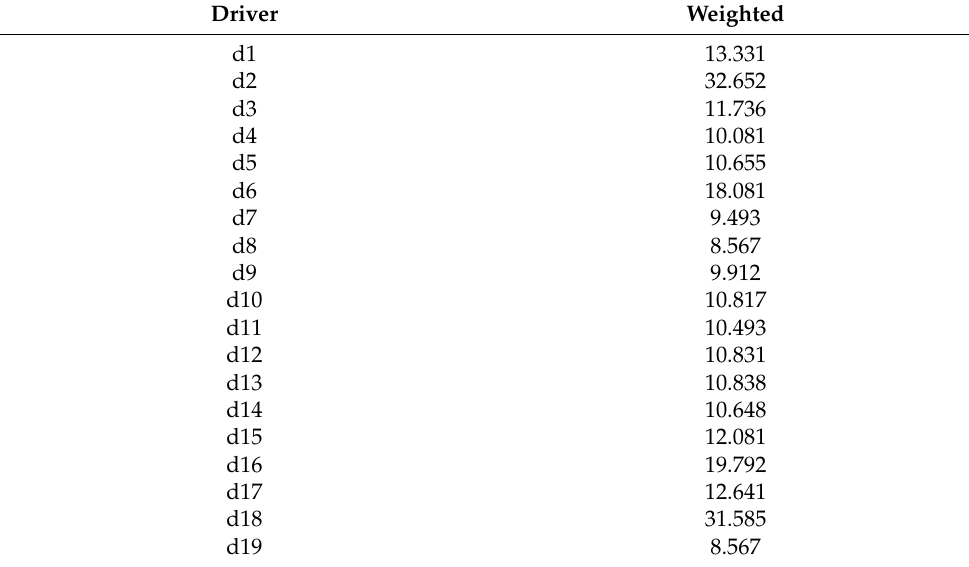
Table 7. DDDI responses